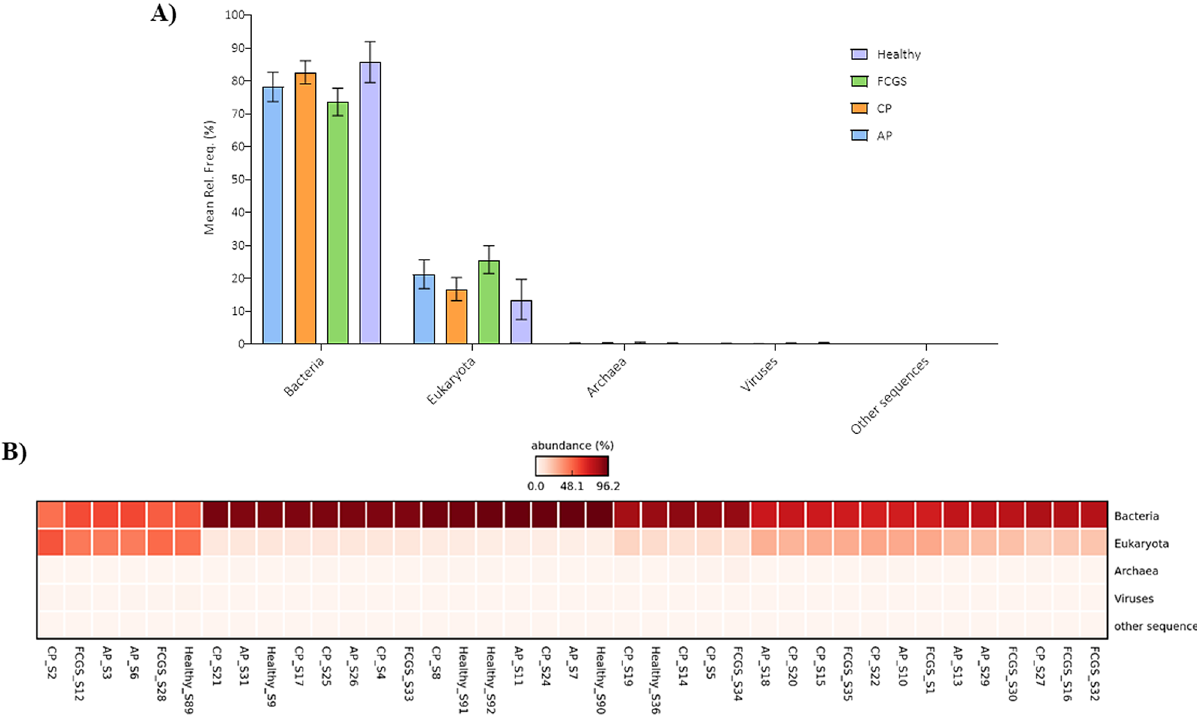
Figure 1. Relative abundance at domain level in subgingival metagenomes from healthy cats and cats diagnosed with aggressive periodontitis (AP_), chronic periodontitis (CP_), and feline gingivostomatitis. ( A ) Bar graph representing the relative distribution (mean relative frequency (%) and standard error of the mean) at domain level among healthy and diseased cats. ( B ) Heatmap plot illustrating abundance (%) at domain level in each metagenomic sample analyzed. ( A ) Generated using GraphPad Prism 9 (GraphPad Software LLC, La Jolla, CA, https:// www. graph pad. com). ( B ) Generated using STAMP v2.1.3 (Statistical Analysis of Metagenomic Profiles) software (https:// beiko lab. cs. dal. ca/ softw are/